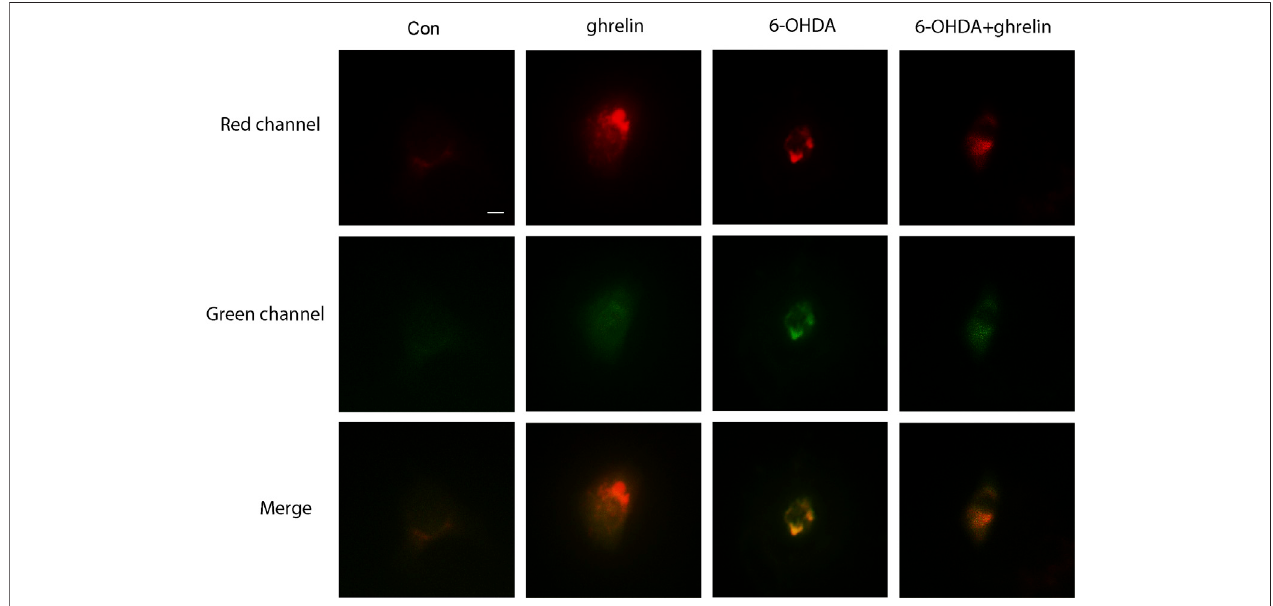
FIGURE 3 | Ghrelin alleviates 6-OHDA-induced autophagic fl ux dysfunction. SH-SY5Y cells infected with Ad-mCherry-GFP-LC3 were treated with ghrelin, 6-OHDA or ghrelin and 6-OHDA for 24 h and the sate of autophagic fl ux was assessed under fl uorescence microscope, scale bar (cid:2) 10 μ